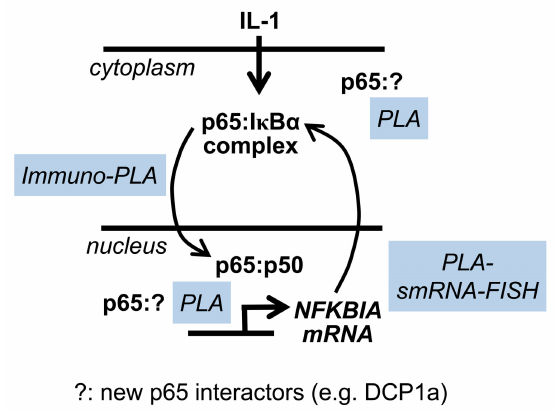
Figure 9. Summary: PLA to study multiple levels of NF- κ B activation in individual tumor cells at the single cell